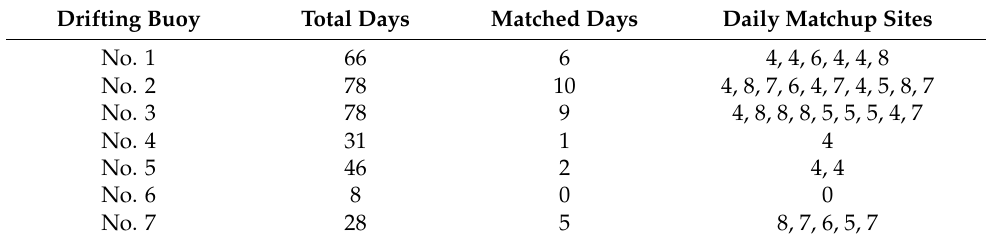
Figure 5. Two types of time series constructed using daily images of GOCI. The sampling location of series-fixed was fixed (the yellow diamond). The sampling location of Series-moving changed (the red dot), which corresponded to the moving water parcel. The first sampling location at 8:30 Beijing time is the same for both time series. Table 2. Matched days and